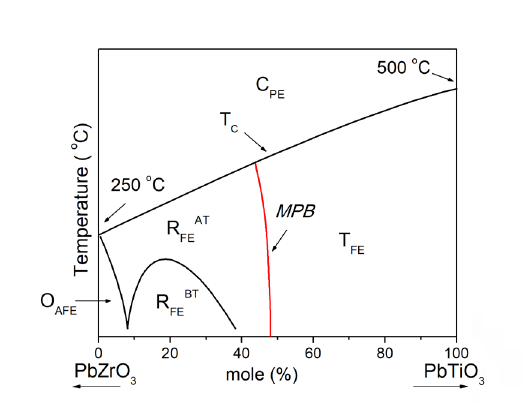
-PbZrO system. The line Figure 1. Phase diagram of the PbTiO 3 3 denoted by MPB ("Morphotropic Phase Boundary") separates the ferroelectric tetragonal region (T ) from the ferroelectric rhombohedral FE BT : low temperature rhombohedral modification; R AT : region (R FE FE high temperature rhombohedral modification). O refers to the AFE orthorhombic antiferroelectric region, while the Tc line indicates the Curie temperature behavior separating the FE and AFE phases ). of the parabolic cubic phase (C PE